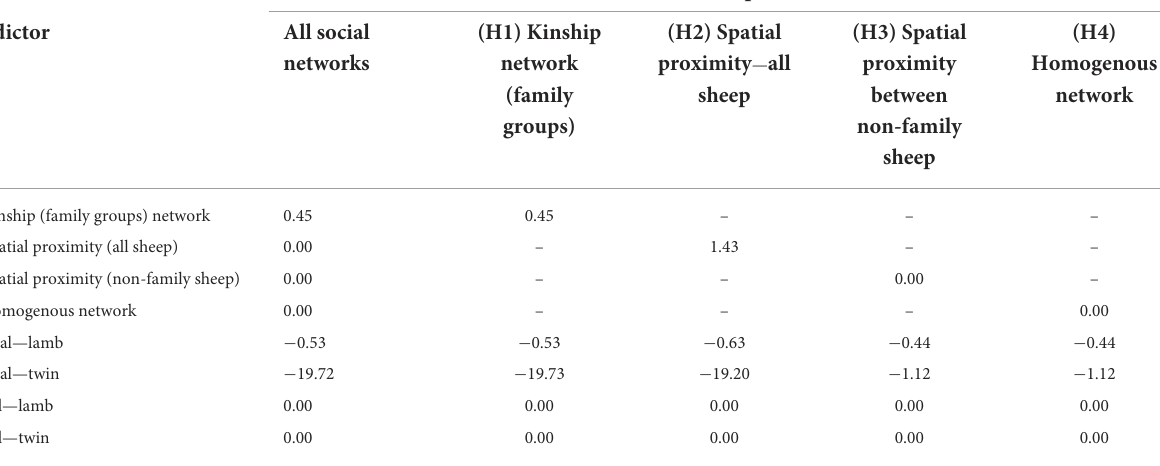
TABLE 5 Median model-averaged terms from the multi-network network-based diffusion analysis, for all social networks combined, and individually for the kinship network of family groups, spatial proximity network of all sheep, spatial proximity of non-family sheep, and the homogenous